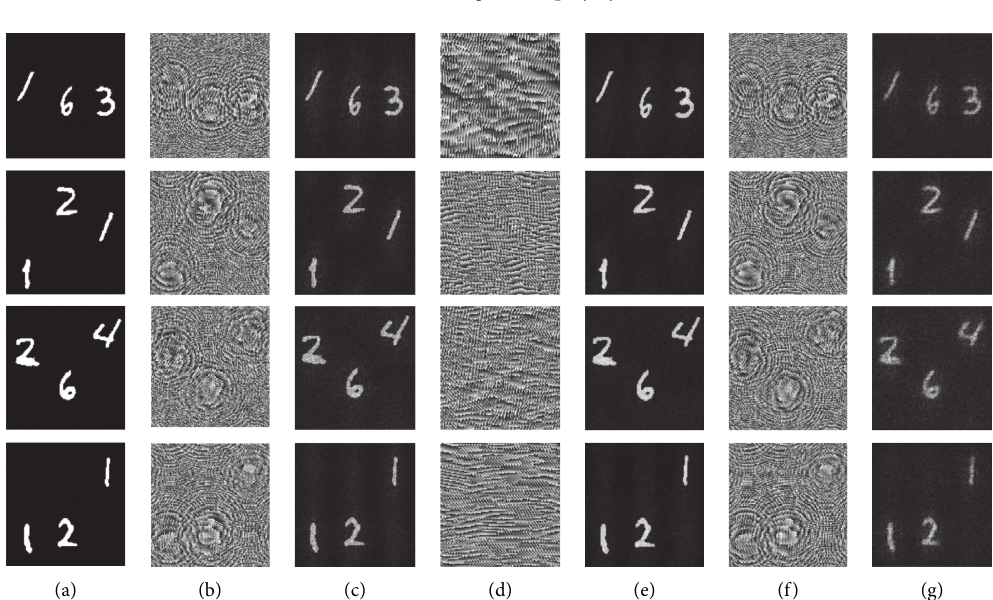
Figure 6: Test result by the GAN-Holo. (a) Target intensity patterns. (b) Hologram of target intensity patterns. (c) Their reconstructed images. (d) Hologram of the Gerchberg–Saxton (GS) method. (e) Their reconstruction images. (f) Proposed method results. (g) Their reconstructed